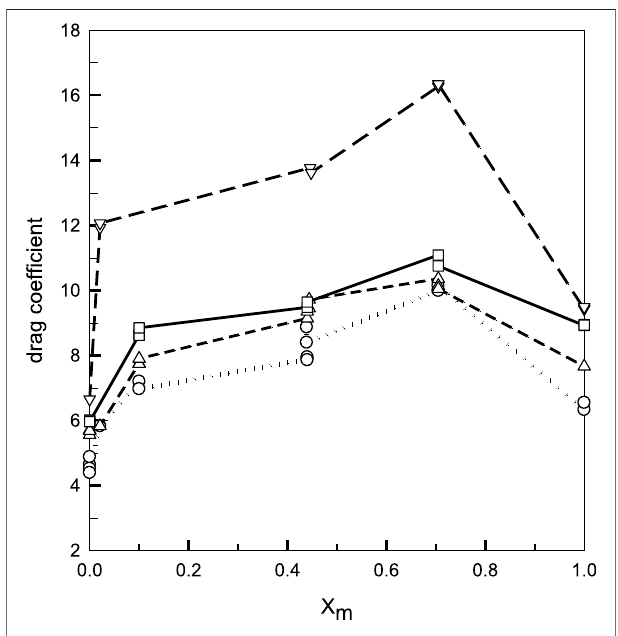
FIGURE 4 | Total drag coef fi cient as a function of methanol concentration at different temperatures: (o) 25 ° C, ( Δ ) 40 ° C, ( □ ) 50 ° C, and ( ∇ ) 60 ° C. The lines are just a guide for the eyes.